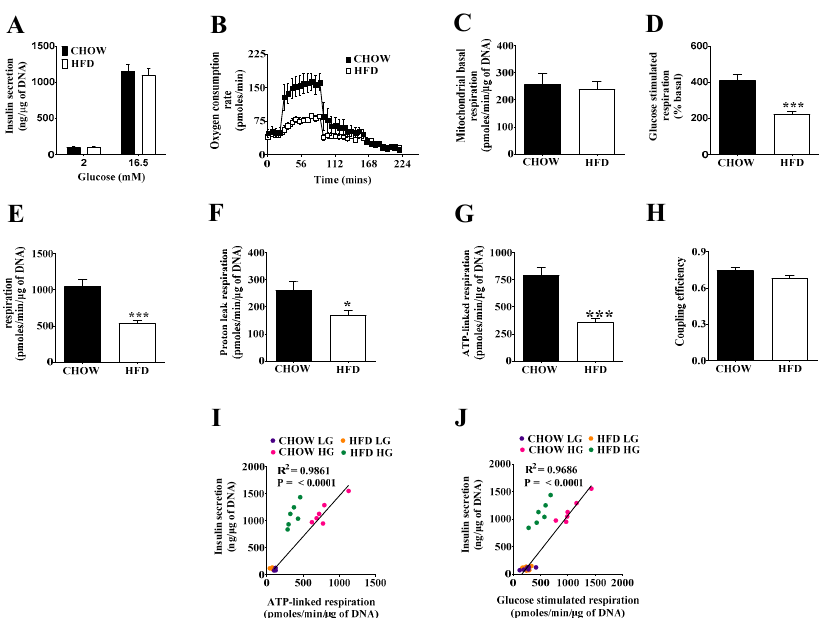
Figure 2. Glucose-stimulated insulin secretion and mitochondrial bioenergetics of pancreatic islets from chow and HFD-fed mice. ( A ) Insulin secretion. Batches of eight size-matched islets were exposed to either 2 or 16.5 mM glucose for 1 h before supernatants and lysates were collected. ( B ) Representative time-resolved oxygen consumption traces. Batches of 30 size-matched islets were exposed to 2 mM glucose to assess basal respiration (4 cycles), glucose-stimulated respiration (10 cycles), proton leak respiration by inhibition of ATP synthase using oligomycin (10 cycles), and non-mitochondrial respiration by final injection of rotenone/antimycin A. ( C ) Mitochondrial basal respiration at low glucose (2 mM). ( D ) Glucose-stimulated respiration expressed as percentage of basal ( E ) Mitochondrial stimulated respiration at high glucose (16.5 mM). ( F ) Proton leak respiration at high glucose. ( G ) ATP-linked respiration at high glucose. ( H ) Coupling effi- ciency at high glucose. ( I ) Correlation of insulin secretion (absolute values) and ATP-linked respiration. ( J ) Correlation of insulin secretion (absolute values) and glucose-stimulated respiration. Data are represented as means ± SEM ( n = 6 mice